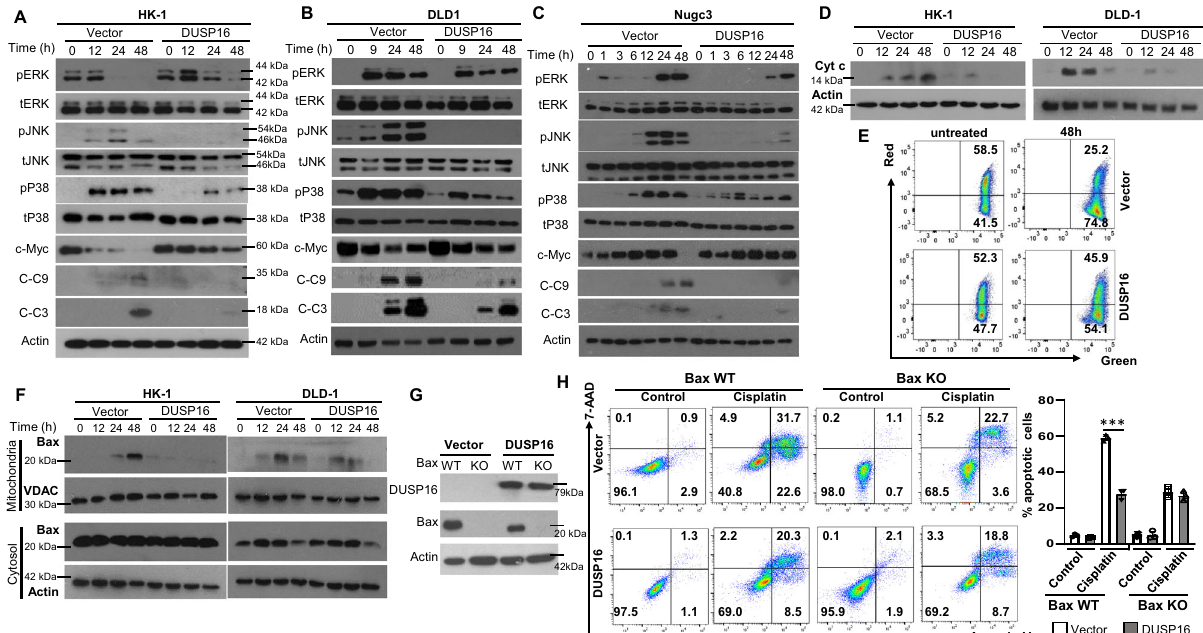
Fig. 4 DUSP16 overexpression suppresses BAX-mediated intrinsic apoptotic pathway in various types of cancer cells in response to cisplatin. A – C Western blot analysis of p-MAPKs, total MAPKs, c-Myc, cleaved caspase 9 (C-C9), and cleaved caspase 3 (C-C3) was carried out on vector- and DUSP16 - transfected HK-1 ( A ), DLD-1 ( B ), and Nugc3 ( C ) cells after cisplatin treatment. The data is representative of at least two experiments with similar results. D Western blot analysis of cisplatin-induced cytochrome c (Cyt c) release in cytosolic fractions of vector- and DUSP16 -transfected HK-1 and DLD-1 cells. The data are representative of three experiments with similar results. E Scatterplots depicting changes in the mitochondrial membrane potential in vector- and DUSP16 -transfected HK-1 cells upon cisplatin treatment. F Western blot analysis of BAX expression in mitochondrial and cytosolic fractions of vector- and DUSP16 -transfected HK-1 and DLD-1 cells. The data are representative of three experiments with similar results. G Western blot analysis of BAX wild-type (WT) and knockout (KO) DLD-1 cell clones with or without DUSP16 overexpression. The data are representative of two experiments with similar results. H BAX WT and KO DLD-1 cells with or without DUSP16 overexpression were treated with cisplatin for 48 h to examine cell apoptosis by staining with AnnexinV + and 7AAD + followed by fl ow cytometry analysis. Bar chart shows the percentage of apoptotic cells with mean values ± SEM, n = 3 biologically independent samples. Statistical analysis was performed using two-tailed unpaired t -test. *** P < 0.0001. The data are representative of three experiments with similar results. Source data are provided as a Source data fi